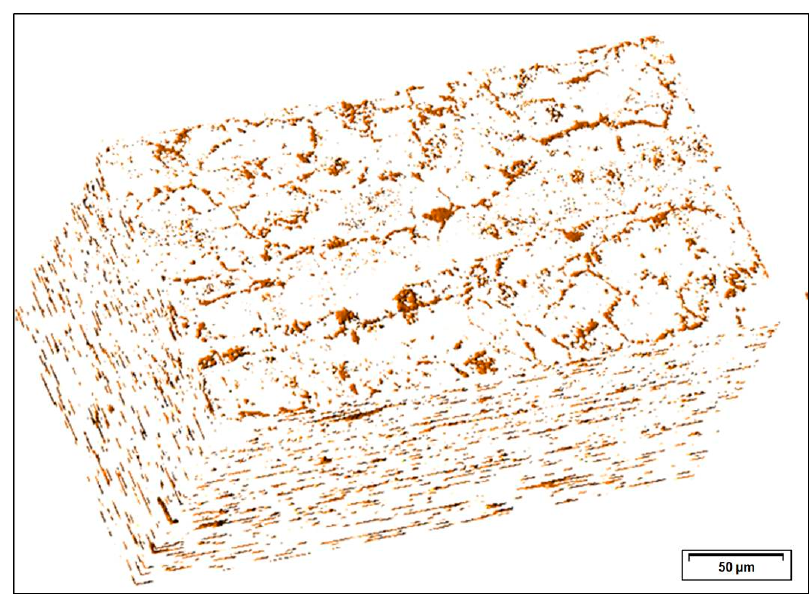
Figure 10. Micrograph of the surface-rendered, reconstructed three-dimensional (3D) microstructure. The micrograph depicts the sigma phase in brown.